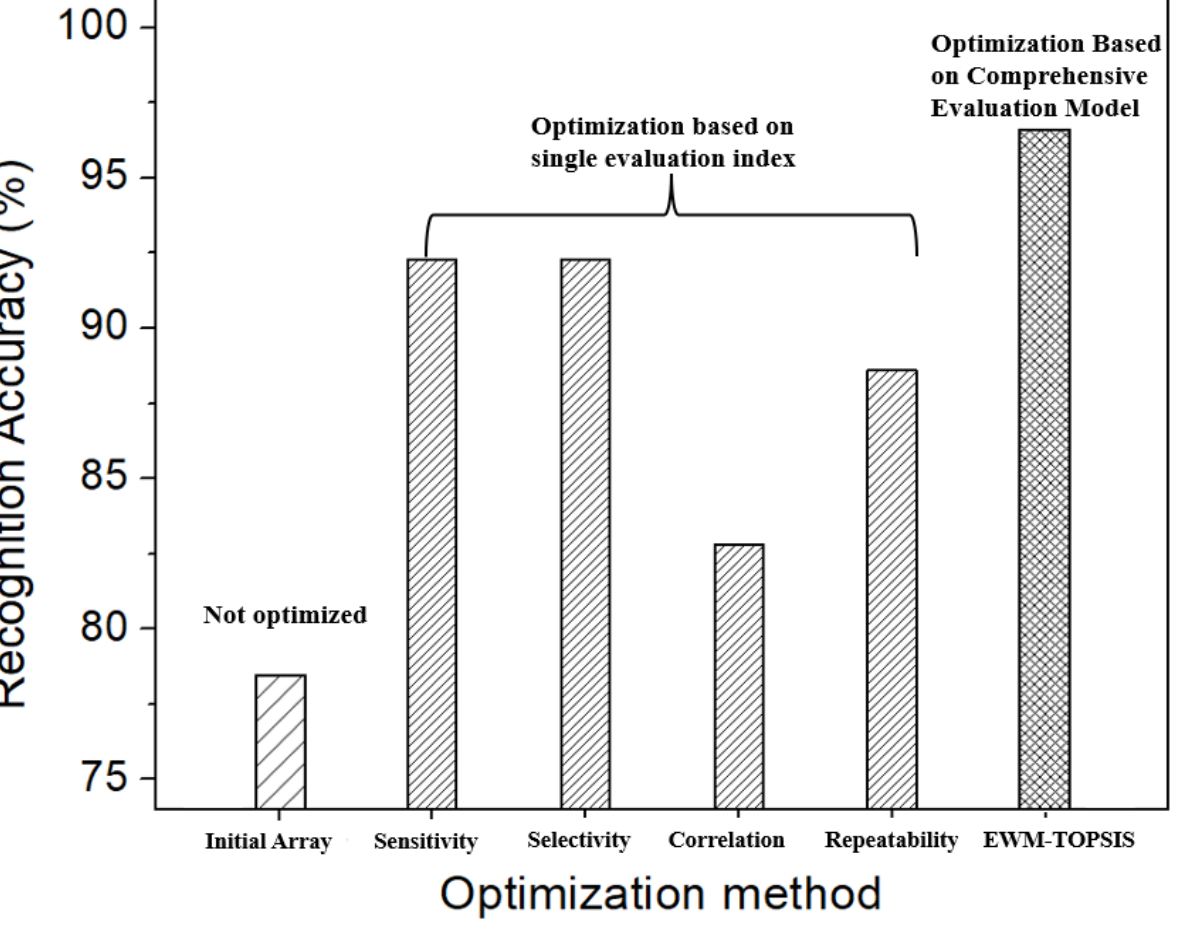
Figure 13. Comparison of recognition accuracy of E-nose with different sensor array optimization methods.